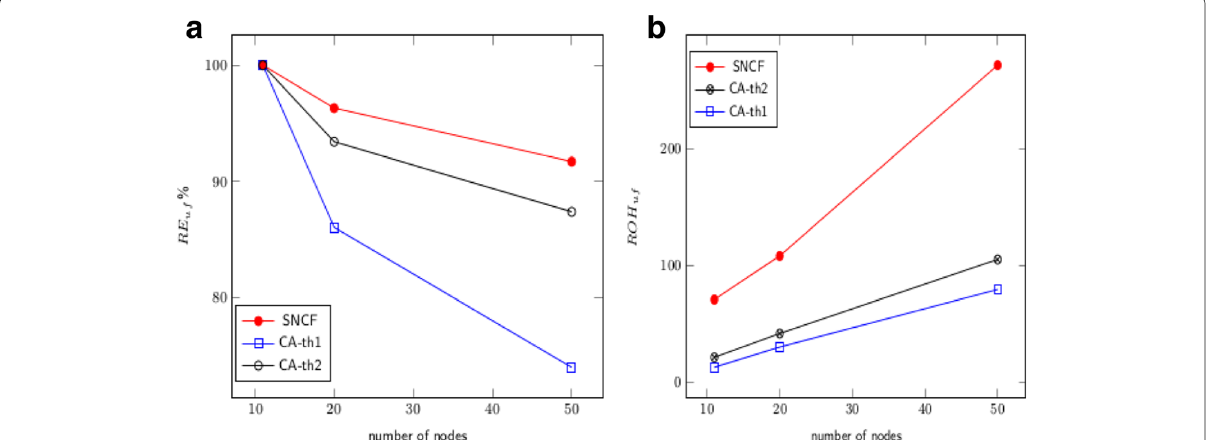
Fig. 24 Reachability ( RE uf ) and redundancy overhead ( ROH uf ) of endcast with SNCF and CA protocols when the network size varies with network density kept constant at 10. a Reachability. b Redundancy